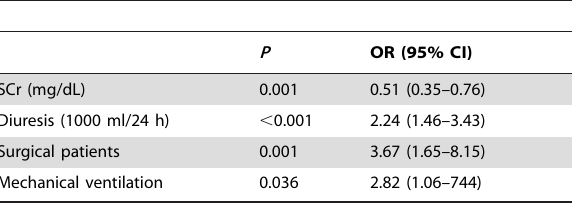
Table 4. Variables retained in the propensity score model for delayed nephrology consultation ( P , 0.05)*.